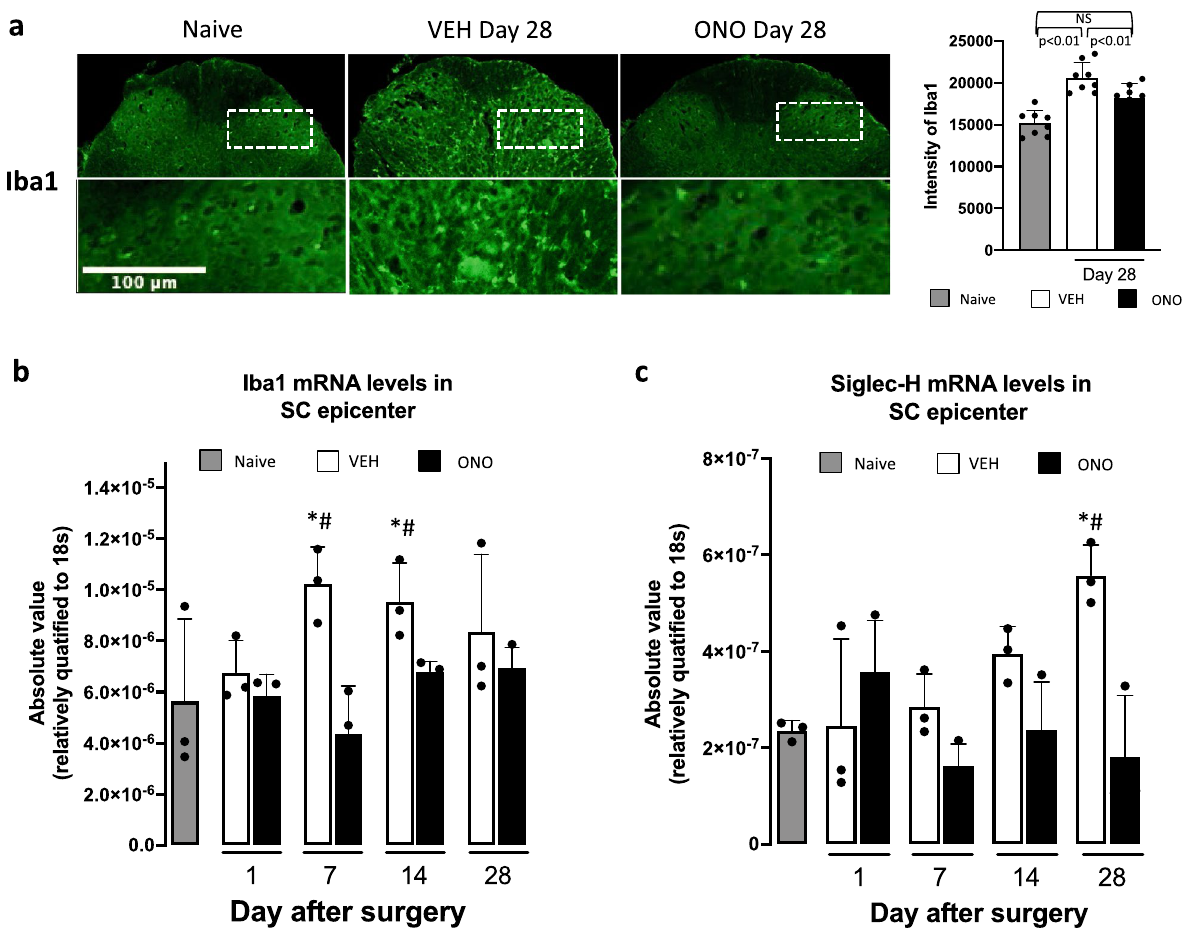
Figure 5. Inhibition of LPA biosynthesis declines an increase of the microglia in injured spinal cord. ( a ) Results represent images of the immunohistochemistry data for single staining of the Iba1 in the dorsal horn at day 28 after model development and their fluorescence intensity of Iba1 in naive, VEH and ONO groups. The fluorescence intensity of Iba1 significantly increased in VEH group in comparison to naïve, whereas in the ONO group, intensity of Iba1 was significantly lower than that of VEH group. Values represent the mean ± SD (n = 8) and significant differences between groups analyzed by one-way ANOVA with Bonferroni correction. The mRNA expression levels of Iba1 ( b ) and Sighlec-H ( c ) in epicenter sections of the spinal cord tissue samples in VEH and ONO groups in comparison to naive at selected time points. Significant enhancement of the Iba1 and Siglec-H expression levels were detected in the VEH group at days 7, 14 and at day 28, respectively. In the ONO group, there were no changes in expression levels of Iba1 and Siglec-H. Values represent the mean ± SD (n = 3). Scales: 100 μm. Symbols indicate significant differences between groups analyzed by one-way ANOVA and paired t-test as follows: VEH, ONO groups with naive: p < 0.05*. VEH, ONO groups between each other at each selected time points: p < 0.05 #